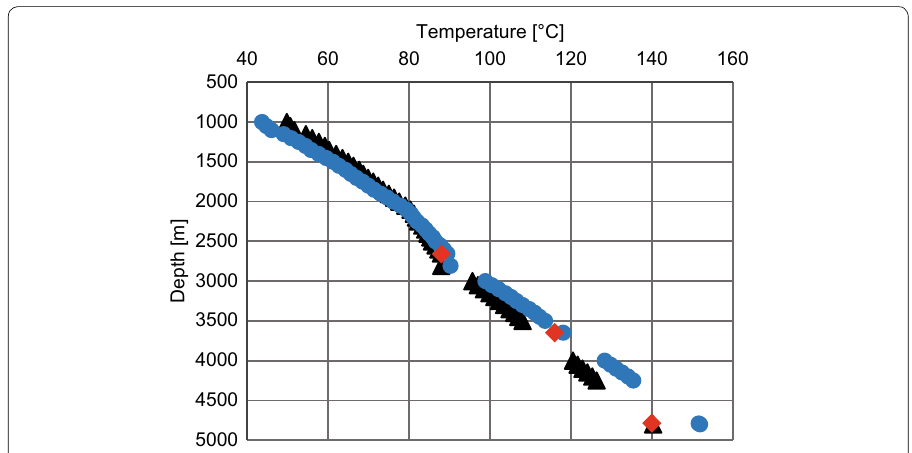
Fig. 11 Overcorrection of temperatures due to log rotation around the cross-over point. Temperature log measurements (black triangles), temperatures recorded during production tests (red diamonds) and log temperature data corrected according to method A (blue